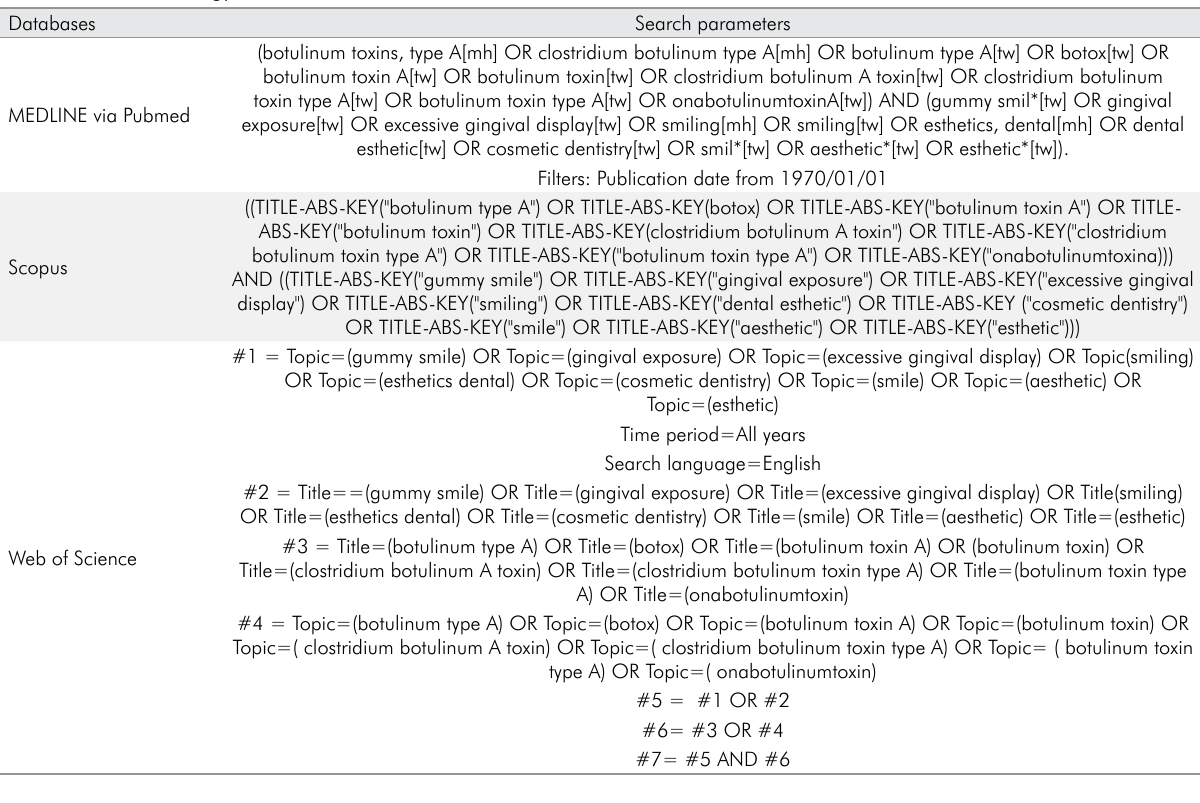
Table 1. Search strategy for each